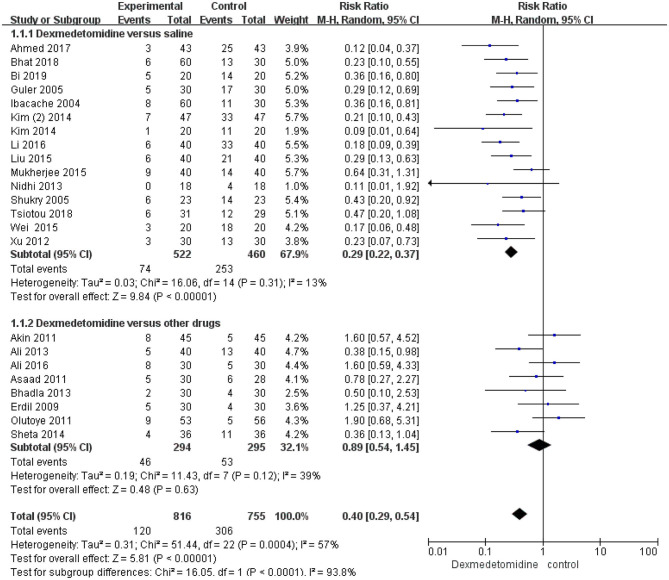
Incidence of emergence agitation (EA): dexmedetomidine vs. saline and other drugs. Forest plot shows that pooled trials were in favor of dexmedetomidine when compared to saline; there was no significant difference between dexmedetomidine and other drugs.